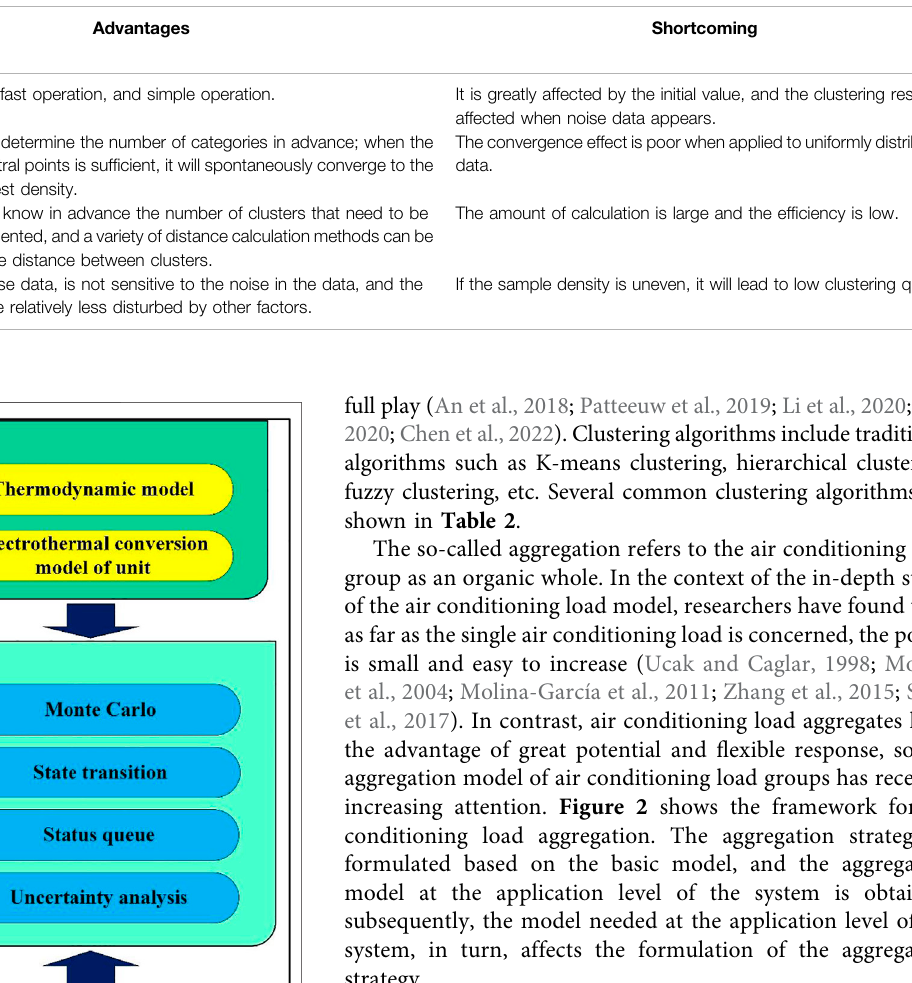
TABLE 2 | Comparison of four Classical clustering methods.